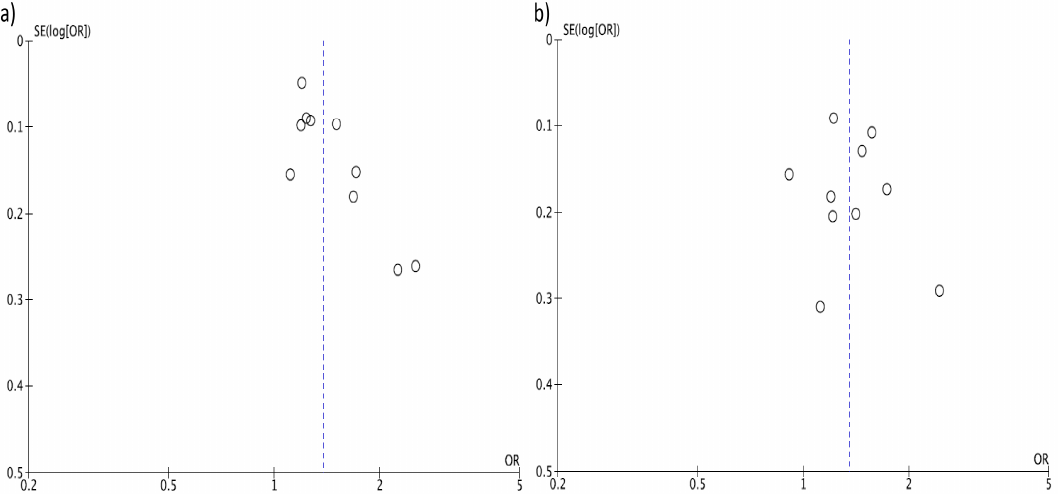
Figure 7. Funnel plots for colon and rectal cancer risk of the highest versus lowest (reference) category of Dietary Inflammatory Index (DII): ( a ) colon and ( b ) rectal.